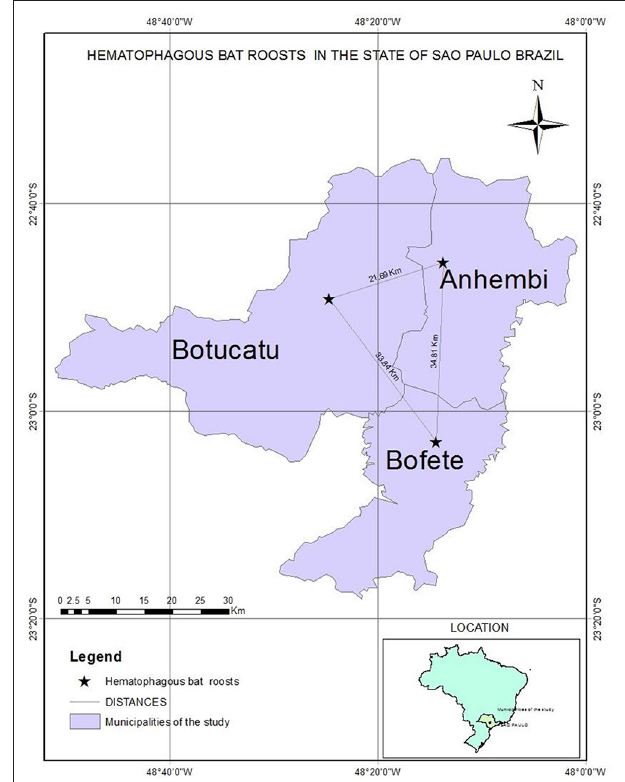
FIGURE 1 | Map showing the three municipalities with different epidemiological